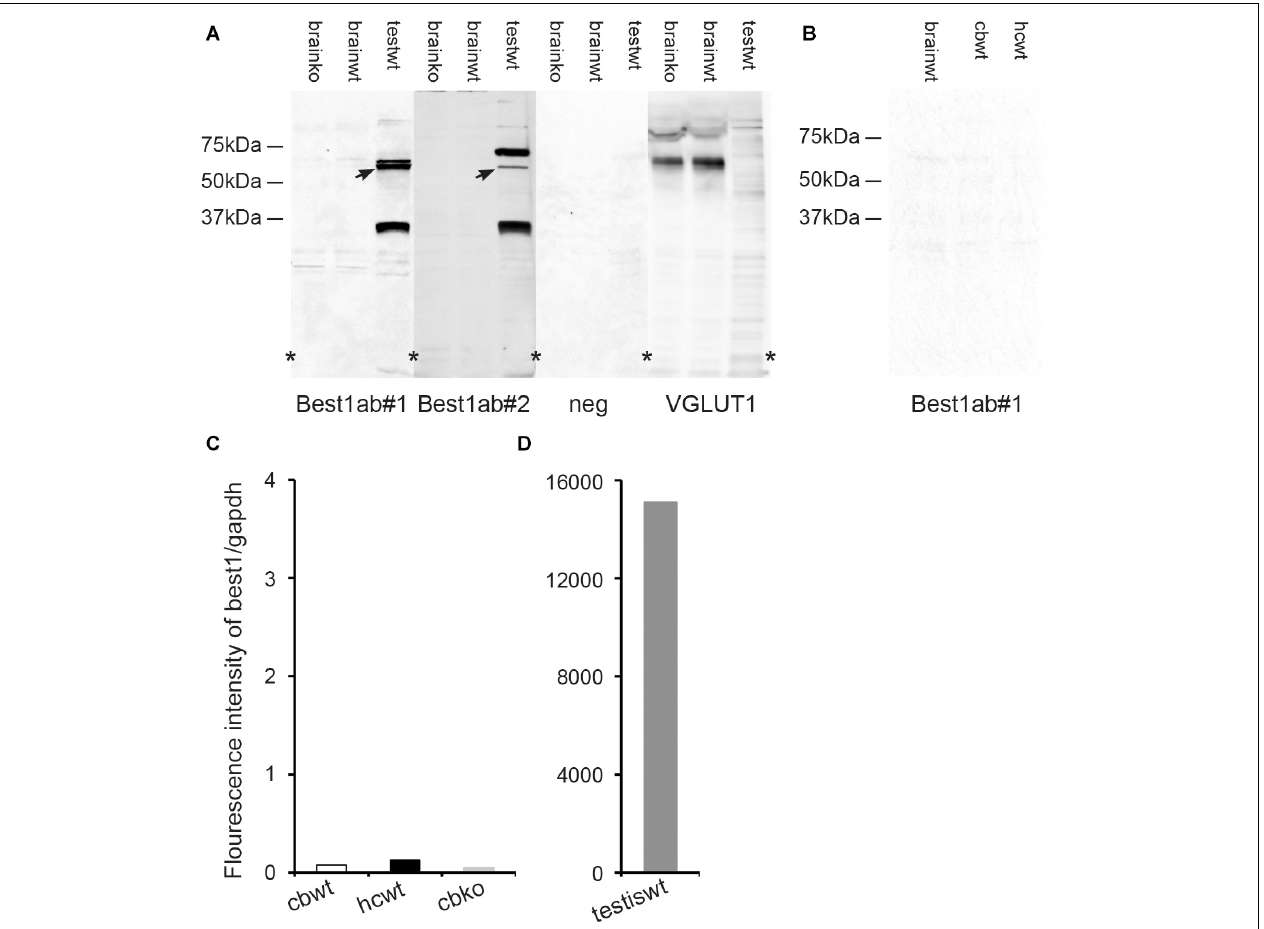
FIGURE 4 | The brain expression of bestrophin-1 is very low. (A) Western blots of the whole brain (20 µ g protein per lane) from wild type (brainwt) and bestrophin-1 knockout (brainko) Balb/c mice, and from the wild type testis labeled with two types of antibodies against bestrophin-1 [Best1ab#1 (1:1000), Best1ab#2 (1:9000), and with antibodies against VGLUT1 (1:9000)]. Note that the bestrophin-1 antibodies do not produce any bands in the brain, while in the testis (testwt) they give a band at about 64 kDa (arrows) (corresponding to the molecular weight of mouse bestrophin-1; Bakall et al., 2003). (B) Western blots of the whole brain (brainwt), the cerebellum (cbwt) and the hippocampus (hipwt) (20 µ g protein per lane) from C57BL/6 mice labeled with antibodies against bestrophin-1 [Best1ab#1(1:1000)]. (C,D) Expression profile of bestrophin-1 mRNA. Quantitative RT-PCR of wild type tissue from the cerebellum (cbwt) and the hippocampus (hipwt), as well as of the bestrophin-1 knockout cerebellum (cbko), and the wild type testis (testiswt). Asterisks: denote splicing marks and that the blots are taken from entire original gels (see Supplementary Figures 8–11